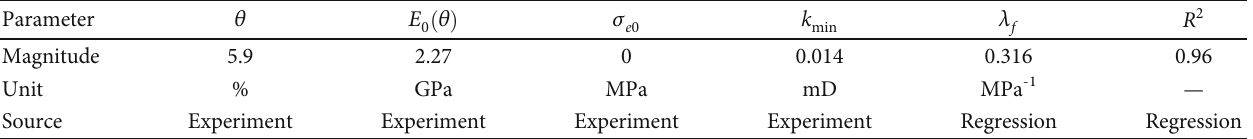
Table 2: Parameters for permeability model